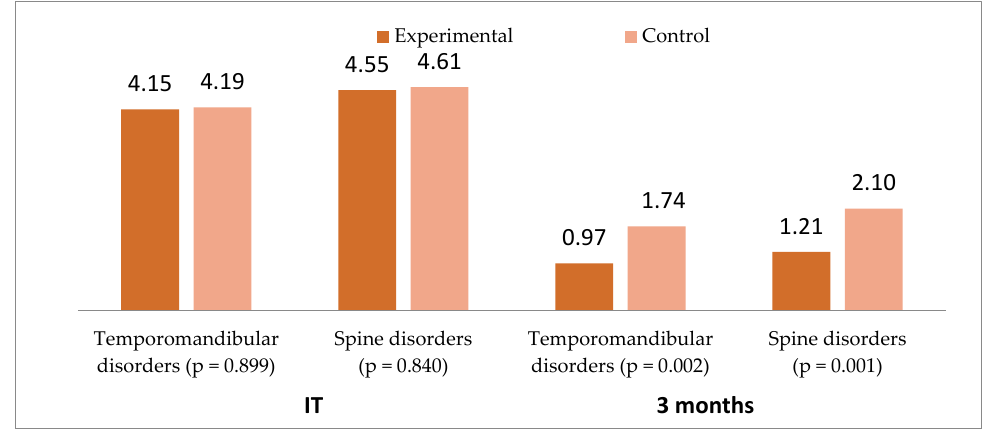
Figure 2. Comparative mean VAS values by study groups (initial (IT) vs. 3 months).